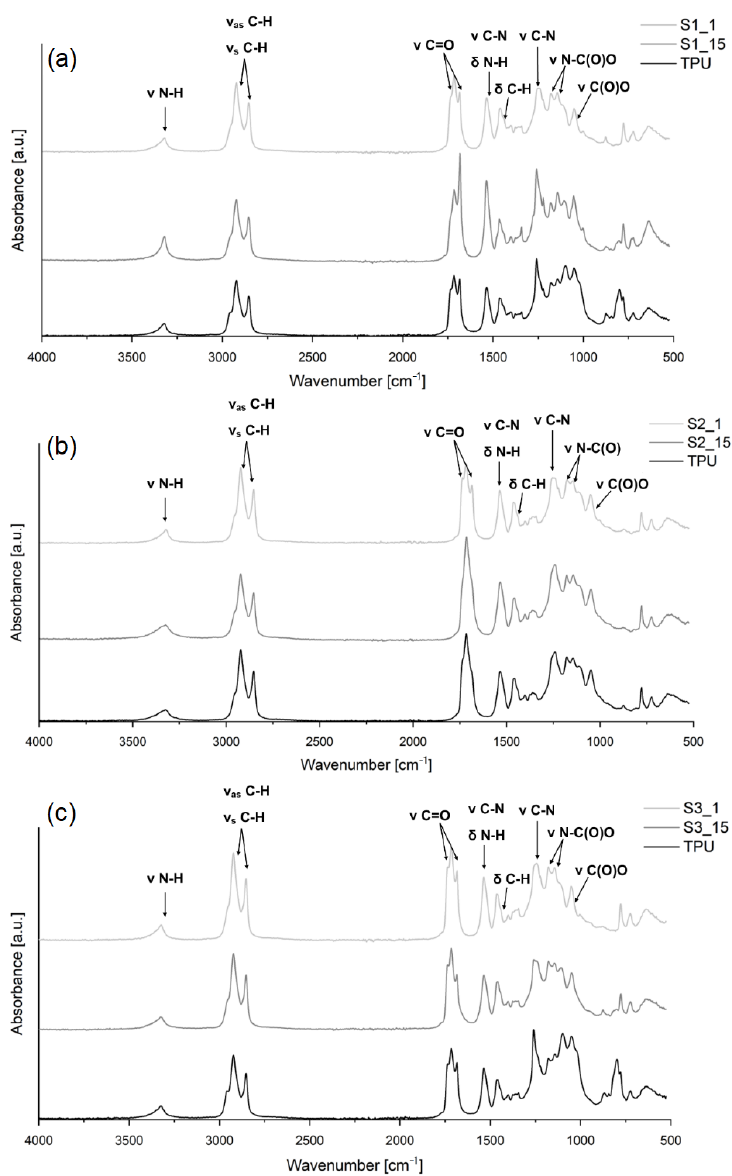
Figure 2. FTIR spectra for TPU composites of each series: ( a ) S1 (bio-TPU based composites containing blend of seagrass Zostera marina and Enteromorpha ); ( b ) S2 (bio-TPU based composites containing Chlorella vulgaris after algal oil extraction) and ( c ) S3 (bio-TPU based composites containing neat Chlorella vulgaris , before algal oil extraction), which confirmed the presence of urethane groups in the structure of matrix (in all series) by peaks occurring at 3320 cm − 1 , 1730 – 1685 cm −1 , 1535 cm −1 , and 1172 – 1050 cm −1 characteristic for NH, C=O, CN, and N-C(O)O bonds and the absence of stretching vibration of NCO at 2250 to 2270 cm −1 [27,28]. If we look closely at particular absorptions, we can notice that the stretching vibration of NH occurred at ca. 3320 cm − 1 and was registered as a single peak, and the wavenumber suggests that most of the NH groups are hydrogen-bonded [27]. At 1529 cm − 1 , two